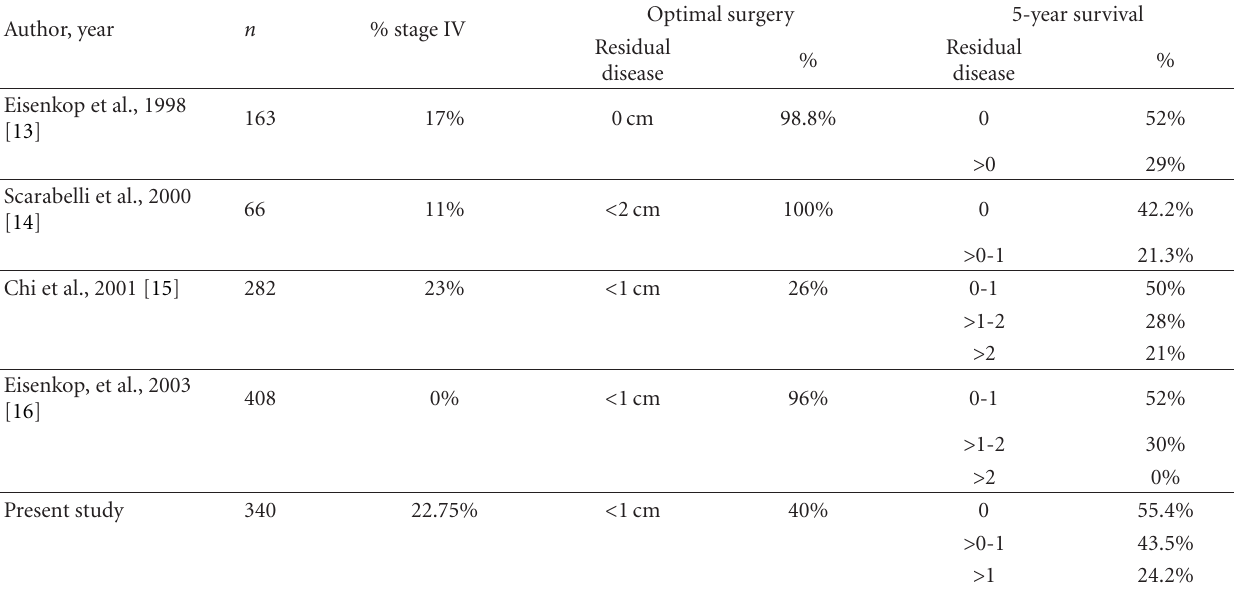
Table 4: Comparison with other